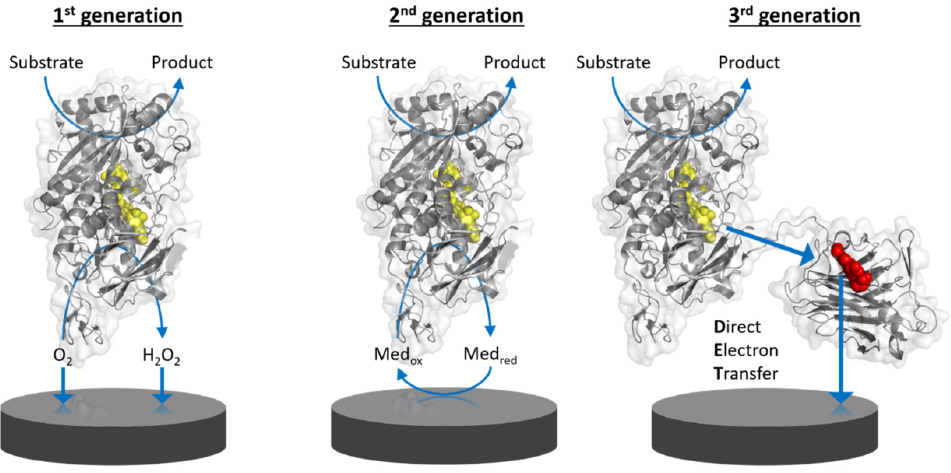
Figure 1. Schematic representation of the working principle of the three generations of enzyme- based amperometric biosensors. 1st generation: based on the electrocatalytic detection of enzymatic substrate conversion or product formation. 2nd generation: based on the electrocatalytic recycling of a redox mediator. 3rd generation: based on direct electron transfer from enzyme to electrode. Yellow molecules depict the FAD cofactor of flavoenzymes and the red molecule depicts the heme cofactor in the mobile cytochrome domain of a multi-cofactor enzyme.